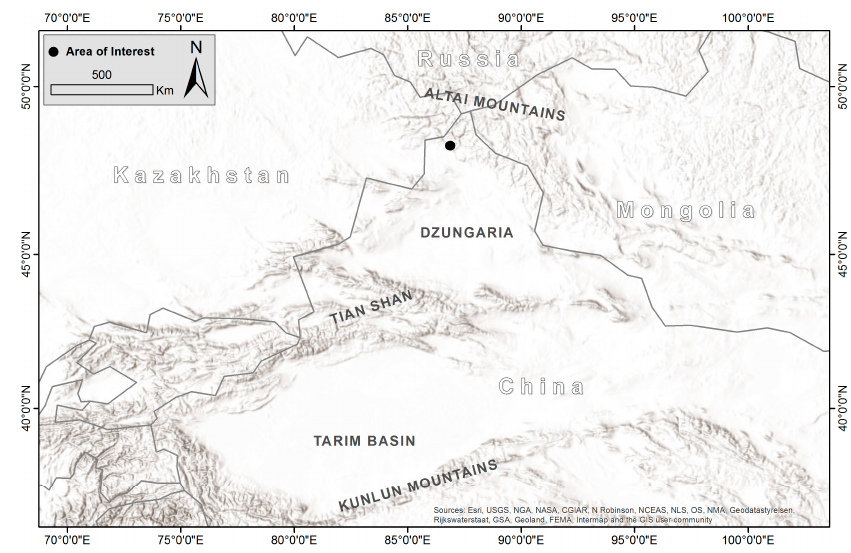
Figure 1. The area of interest in the Altai Mountains.